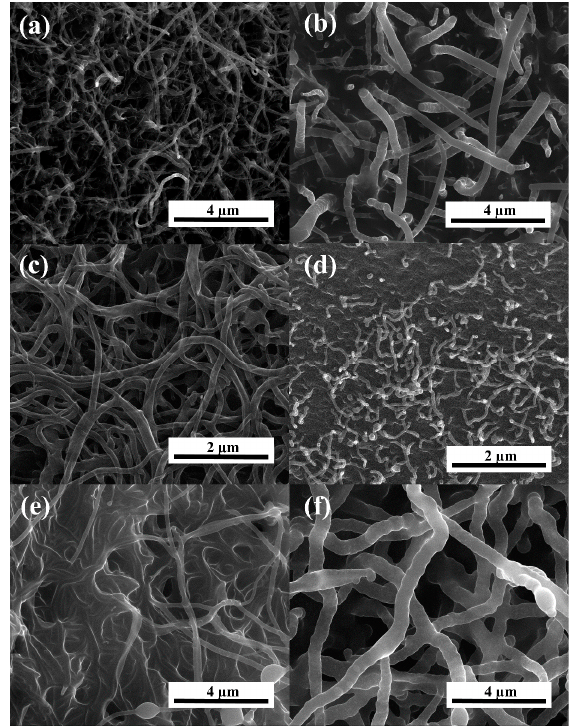
Figure 1. S canning electron microscope (SEM) images for samples: ( a ) C1-6; ( b ) C1-A-6; ( c ) C1-7; ( d )